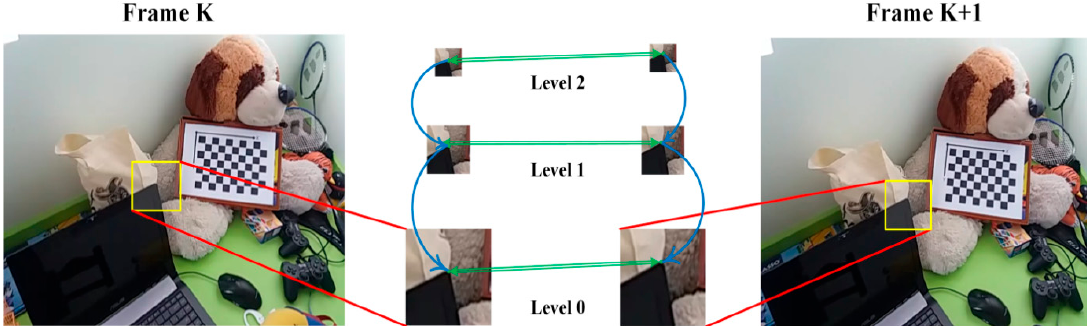
Figure 2. Pyramidal implementation for feature tracking in two consecutive frames.